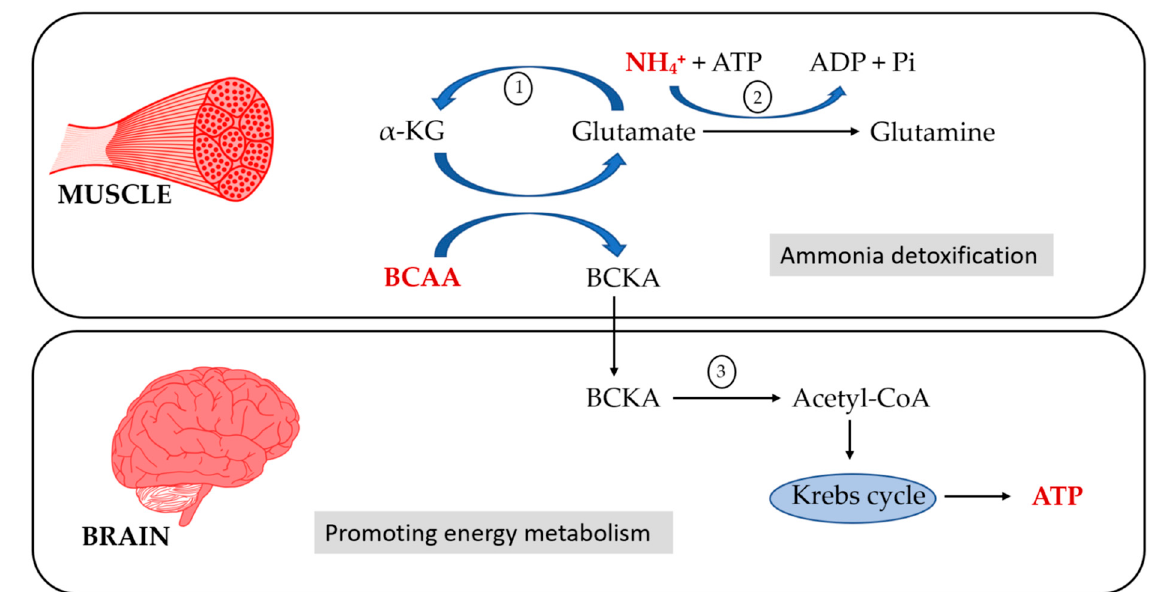
Figure 4. Pathophysiological mechanisms by which BCAA supplementation improves hepatic encephalopathy symptoms. BCAA: branched-chain amino-acid, BCKA: branched-chain keto acid, α -KG: α -ketoglutarate. Numbers represent key enzimes of the process; 1: glutamate dehydrogenase, 2: glutamine synthetase, 3: ranched-chain α -keto acid dehydrogenase complex.